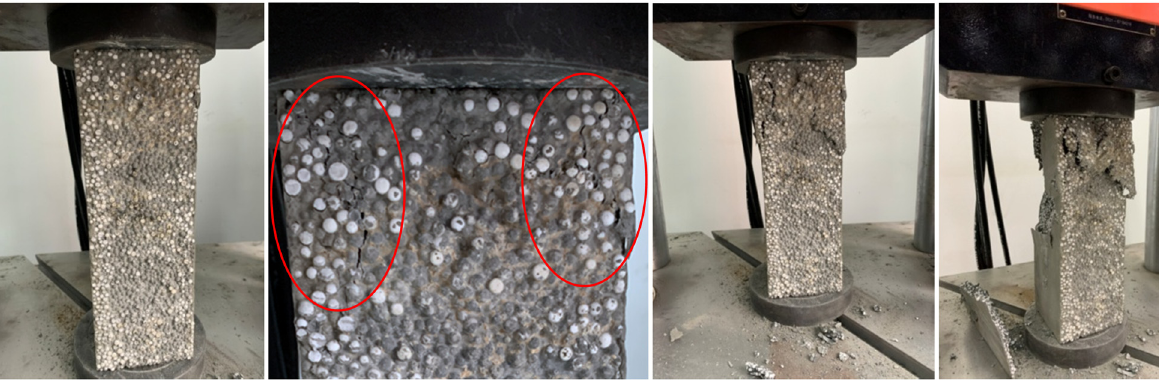
Figure 5: Failure mode of group Y specimens.